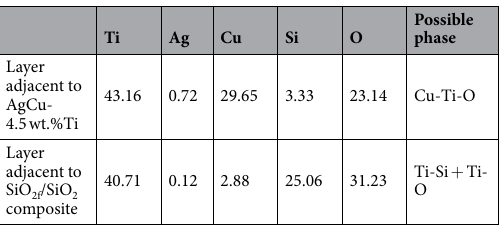
Table 1. Composition (at%) of layers in Fig.